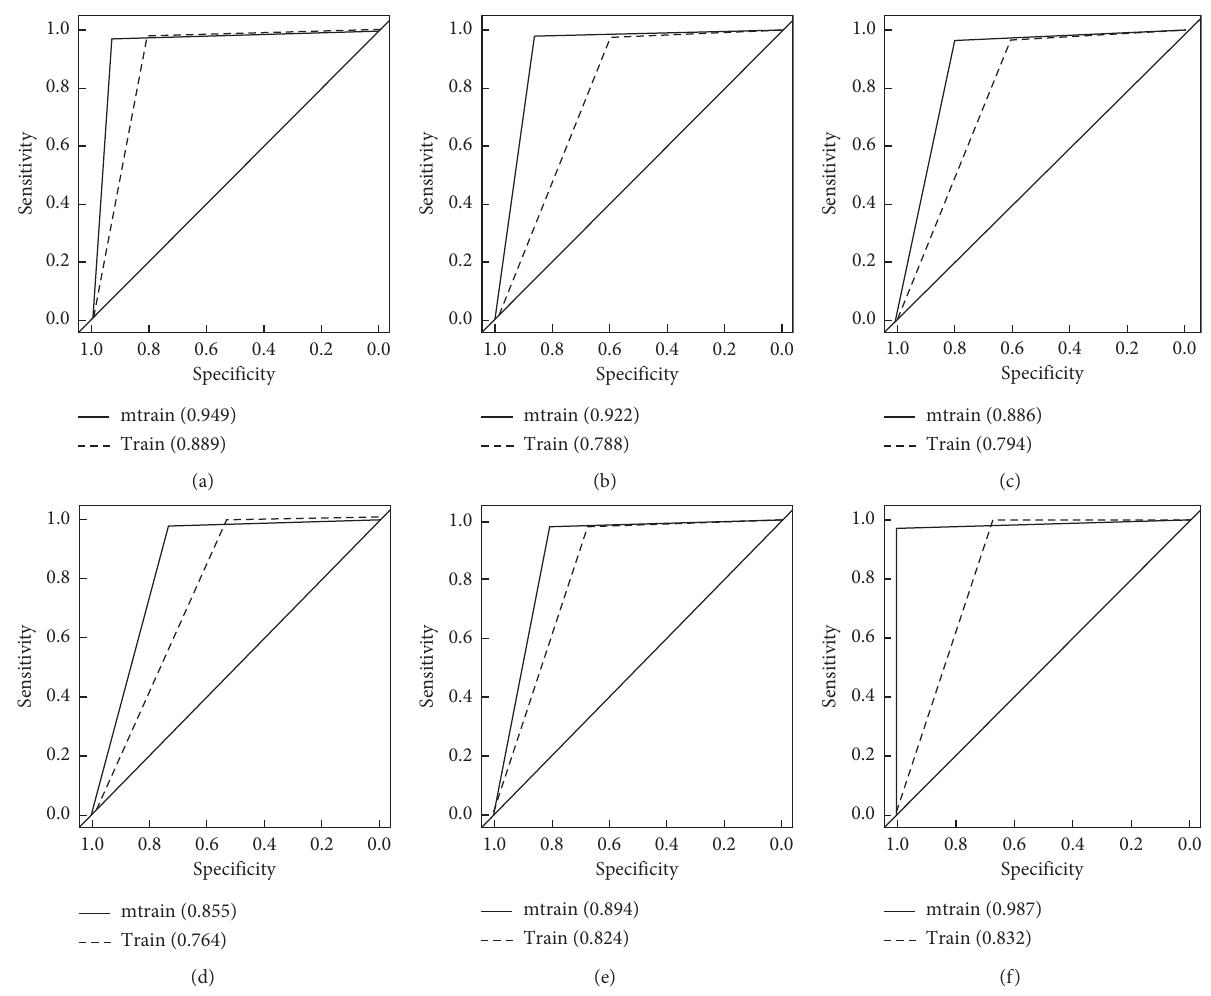
Figure 3: ROC curve of each model. (a) CART. (b) C45. (c) AdaBoost. (d) SVM. (e) RF. (f)